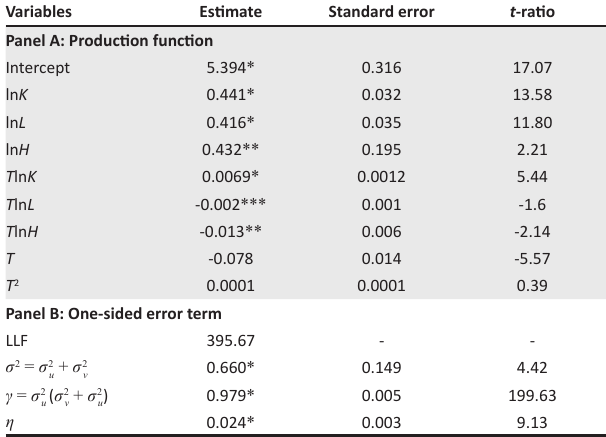
TABLE 5: Frontier